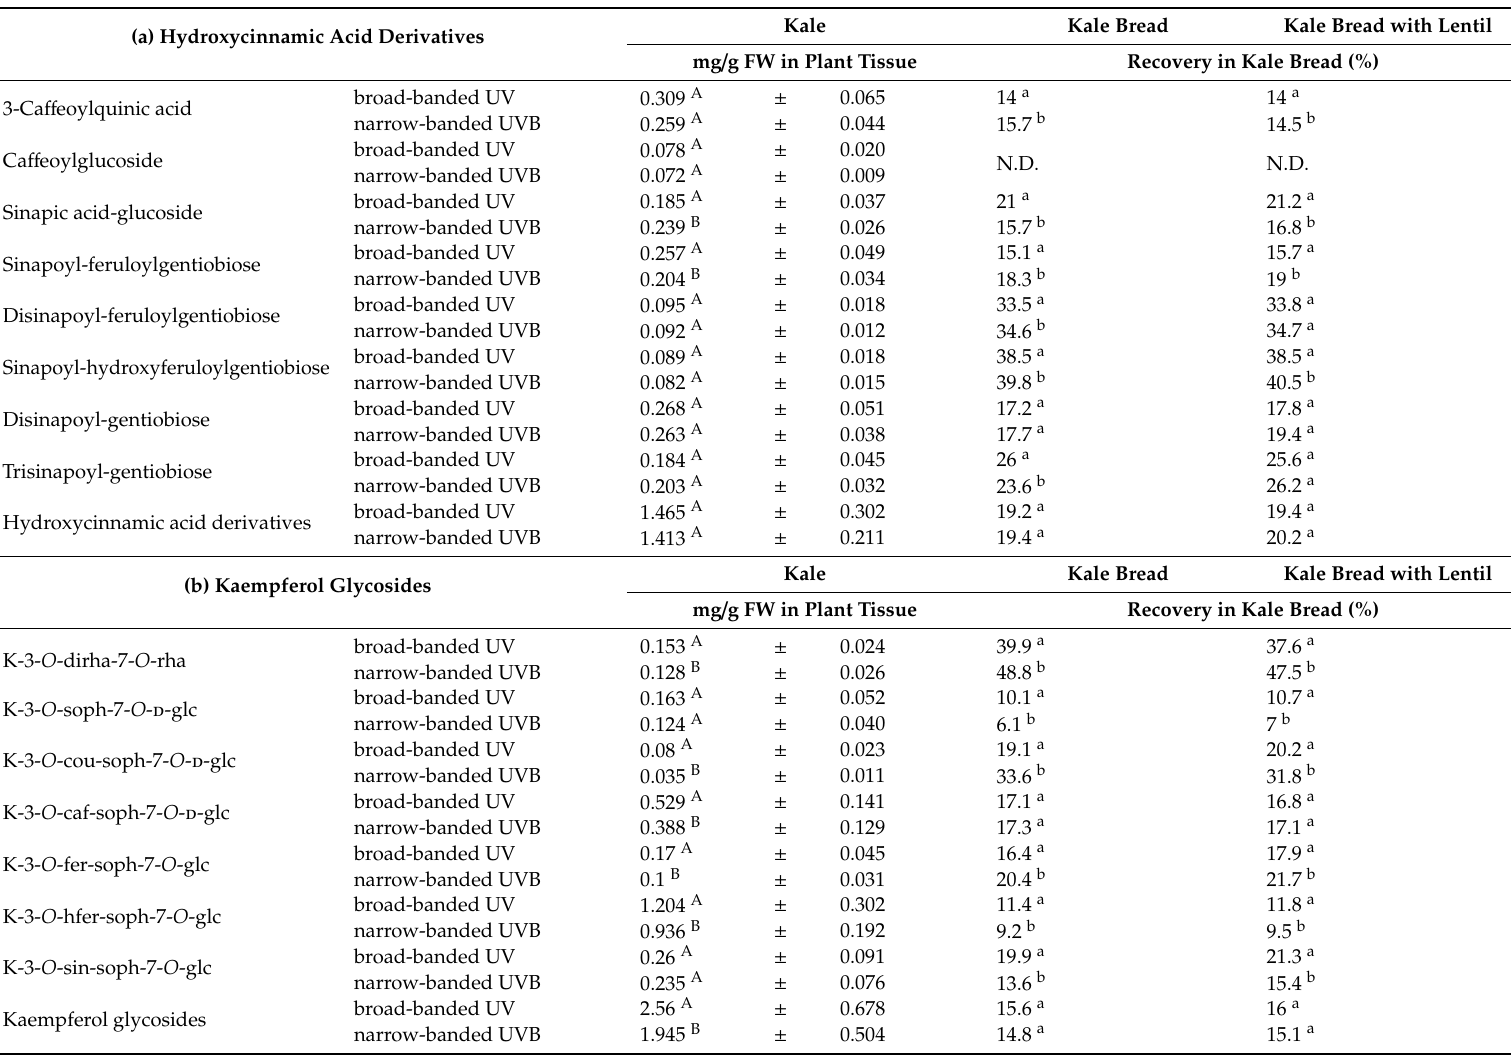
Table 2. Influence of narrow-banded UVB and breadmaking on ( a ) Hydroxycinnamic acid derivatives, ( b ) Kaempferol glycosides, and ( c ) Quercetin glycosides, in kale leaves. Abbreviations: caf: ca ff eoyl; cou: coumaroyl; fer: feruloyl; glc: glucoside; HCA: hydroxycinnamic acids; hfer: hydroxyferuloyl; k: kaempferol; q: quercetin; rha: rhamnoside; sin: sinapoyl; soph: sophoroside; sophtr: